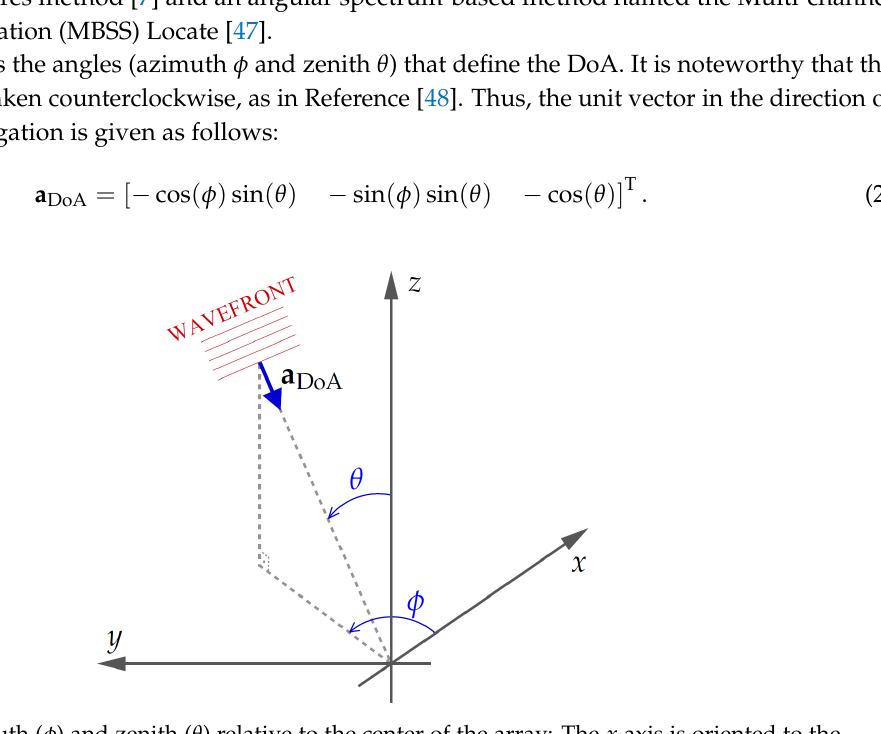
Figure 2. Azimuth ( φ ) and zenith ( θ ) relative to the center of the array: The x axis is oriented to the front of the drone, and the z axis points